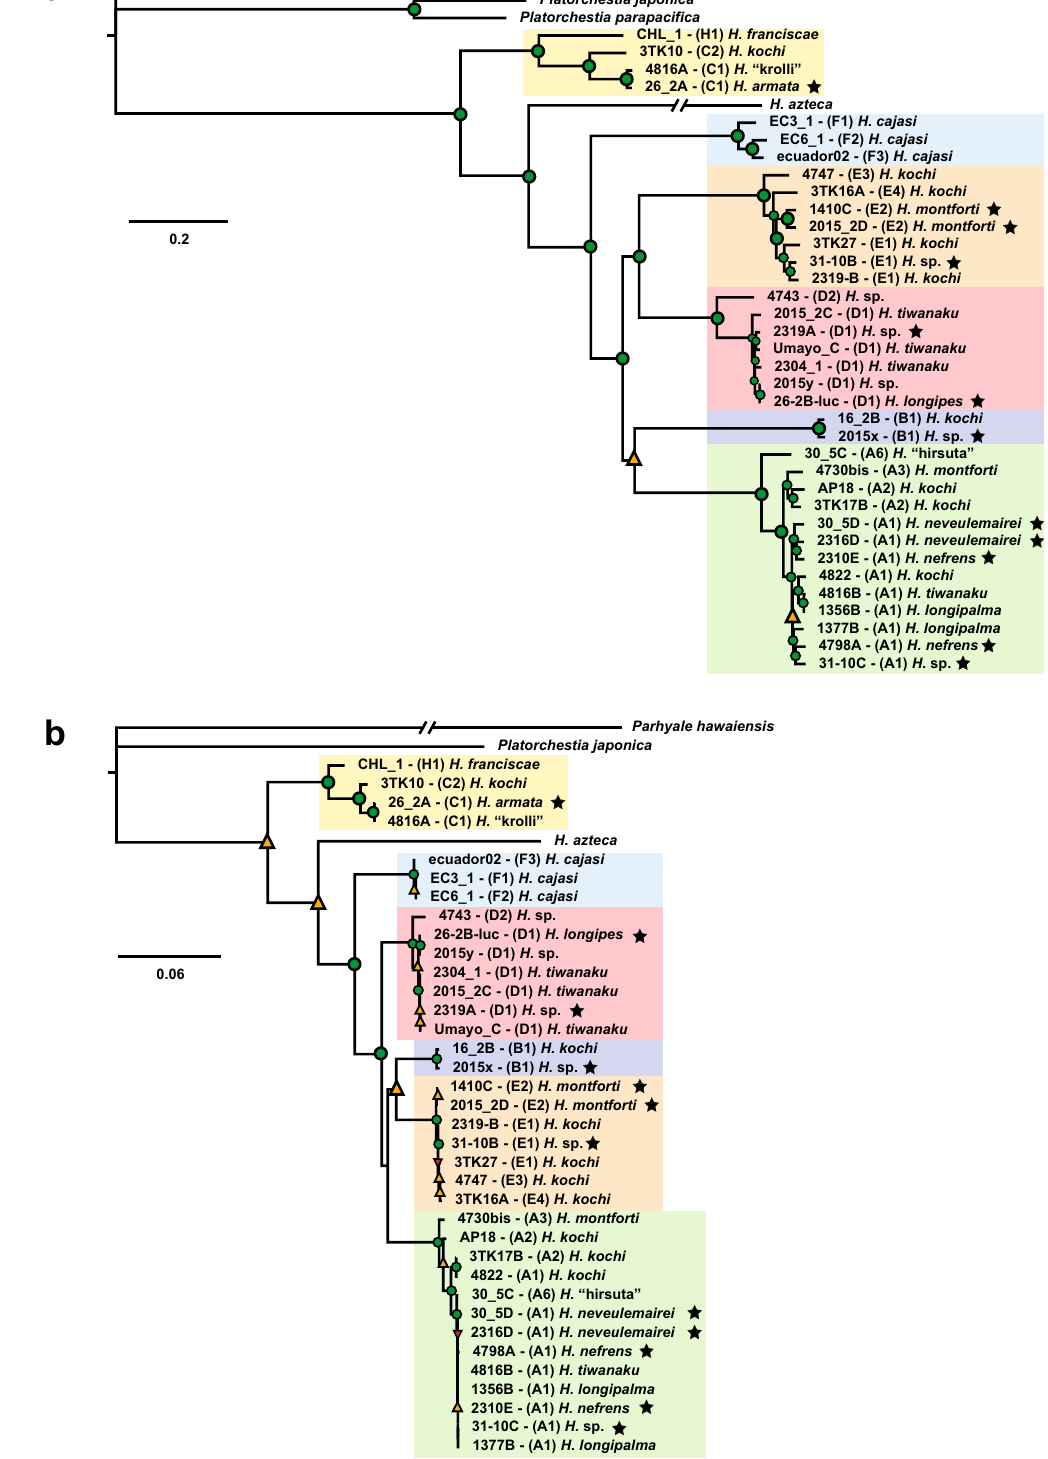
Figure 2. ( a ) Maximum Likelihood phylogeny based on the 13 mitochondrial protein-coding genes of Hyalella and outgroup taxa. ( b ) Maximum Likelihood phylogeny based on LSU and SSU nuclear rDNA sequences. Colours for different lineages define the main clades (see main text for details and Fig. 4). Trees are available in nexus format in the GitHub repository (https ://githu b.com/Fraza pel/Hyale lla-amphi pod-Phylo genom ics). Nodes in a and b are marked with different colours to indicate bootstrap support: green circles (maximum nodal support, i.e. 100), orange triangles < 96 and red triangles < 80%. Stars denote species with armoured spiny